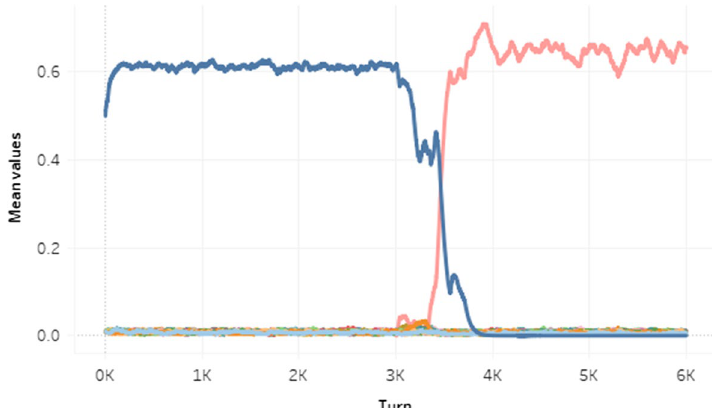
Fig. 8 Airdrop, case 2-A: Time series of the mean of view. Case 2-A is a case in which cryptocurrency can be selected as a utility (with the cryptocurrency agent) and 1 unit is distributed to one specific person each turn. Blue line is the fiat money good, red line is the cryptocurrency good, and other colors represent remaining goods. After turn 3001 of cryptocurrency good introduction, the view increases rapidly and the cryptocurrency acquires a monetary function. On the other hand, the view of the fiat money good decreases in response and loses its function as money